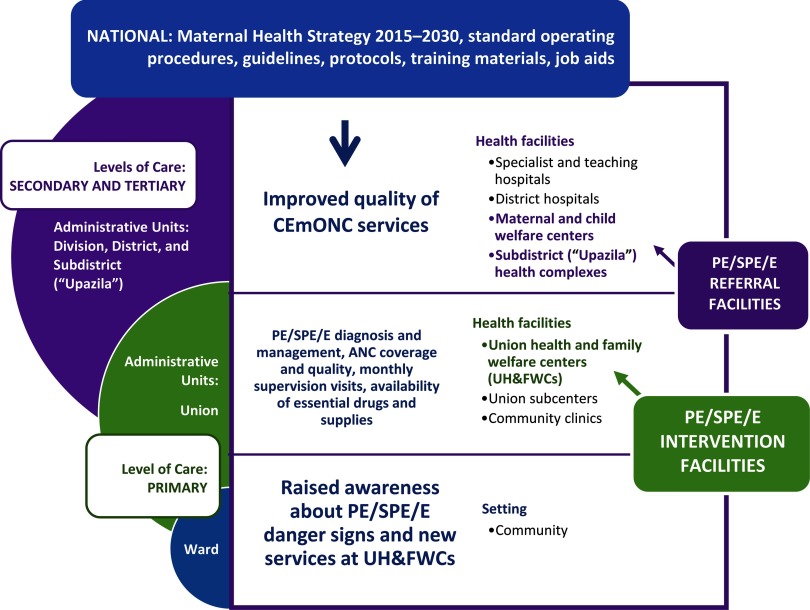
MaMoni HSS Project's Maternal Health Interventions in BangladeshAbbreviations: ANC, antenatal care; CEmONC, comprehensive emergency obstetric and neonatal care; HSS, Health Systems Strengthening; PE/SPE/E, preeclampsia, severe preeclampsia, or eclampsia.